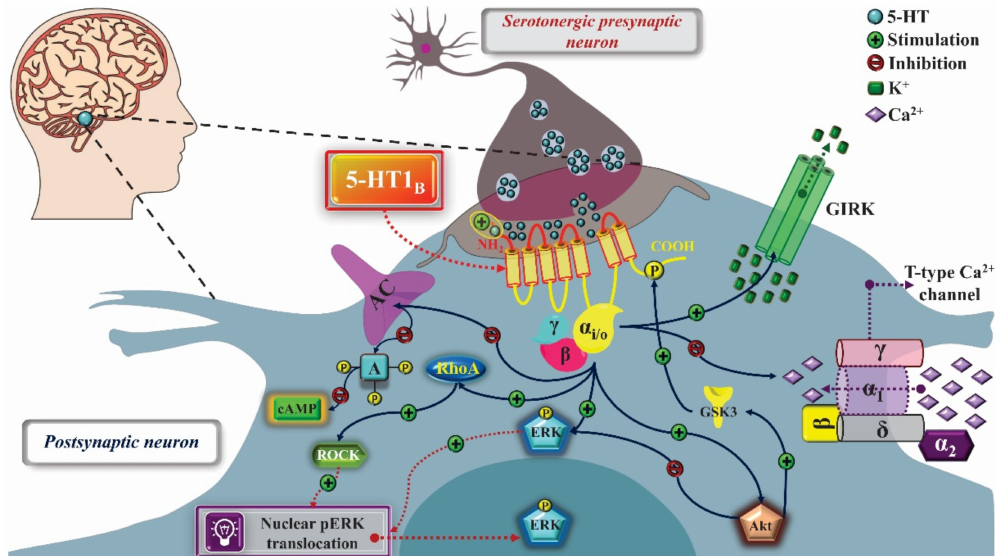
Figure 2. 5-HT 1B receptor signaling pathways. The 5-HT 1B receptor is coupled to the G α i/0 protein. Its activation blocks the activity of adenylate cyclase (AC), reducing the conversion of adenosine triphosphate (ATP) into cyclic adenosine monophosphate (cAMP), which is responsible for the activation of protein kinase A (PKA). The activation of these receptors decreases the release of neurotransmitters in neurons through opposite changes in K + (increase) and Ca 2+ (decrease) conductances. After 5-HT 1B activation, a cascade of kinases regulates the translocation of extracellular signal regulated kinase (ERK) (transcription activation) [12]. In addition, kinase B protein (AKT) is stimulated with consequent activation of glycogen synthase kinase 3 (GSK3), which is involved with phosphorylation and regulation of the 5-HT 1B receptor activity